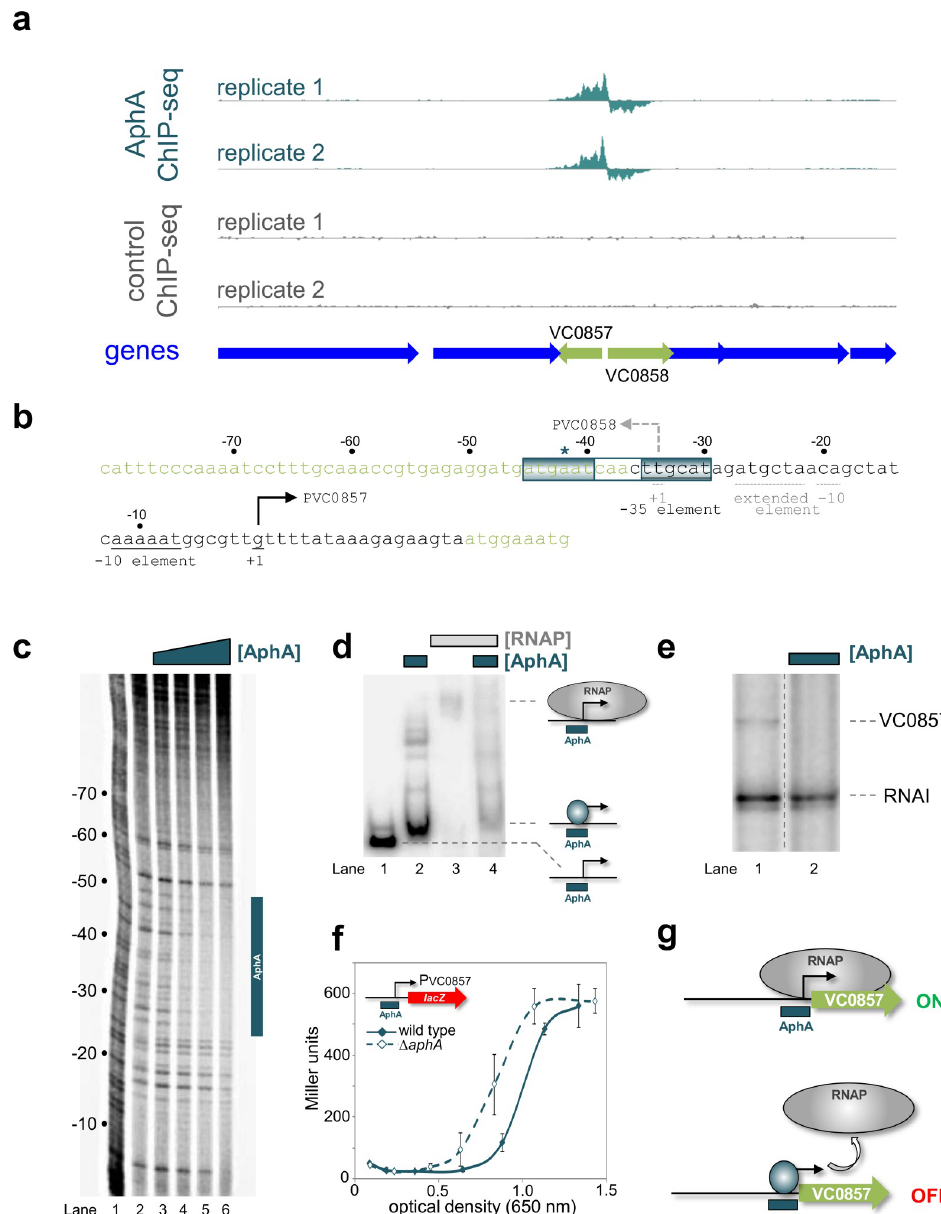
Fig 2. Repression of VC0857 expression by AphA. (a) AphA binding between VC0857 and V0858. Genes are shown as block arrows. ChIP-seq coverage plots are shown for individual experimental replicates. Data for AphA are in teal and control profiles are grey. Signals above or below the horizontal line correspond to reads mapping to the top or bottom strand respectively. (b) DNA sequence of the intergenic region between VC0857 and VC0858. For clarity, the sequence orientation has been inverted. Coding DNA sequence is light green. Bent arrows denote transcription start sites for VC0857 (solid line) and VC0858 (broken line). Promoter elements are labelled similarly. Distances (bp) are with respect to the VC0857 transcription start site. The teal asterisk denotes the ChIP-seq peak centre. The AphA binding site is boxed and labelled. (c) DNase I footprint of AphA bound at the intergenic region. Lane 1 is a Maxim- Gilbert ‘G+A’ ladder. Where added, the concentration of AphA was 0.25, 0.50, 1.00 or 2.00 μ M. The footprint is indicated with a vertical teal bar. (d) AphA prevents RNA polymerase binding. Electrophoretic mobility shift assay showing mobility the VC0857-VC0857 intergenic DNA (lane 1), with 0.5 μ M AphA (lane 2), 0.4 μ M RNA polymerase (lane 3), or both factors (lane 4). (e) AphA represses VC0857 in vitro . The gel shows the result of an in vitro transcription experiment. Experiments were done with 0.4 μ M RNA polymerase in the absence (lane 1) or presence (lane 2) of 1 μ M AphA. The RNAI transcript acts as an internal control. The VC0857 transcript is labelled. No transcript was detected for the VC0858 promoter (see full gel image in S6 Fig, labelled red). (f) Activity of the